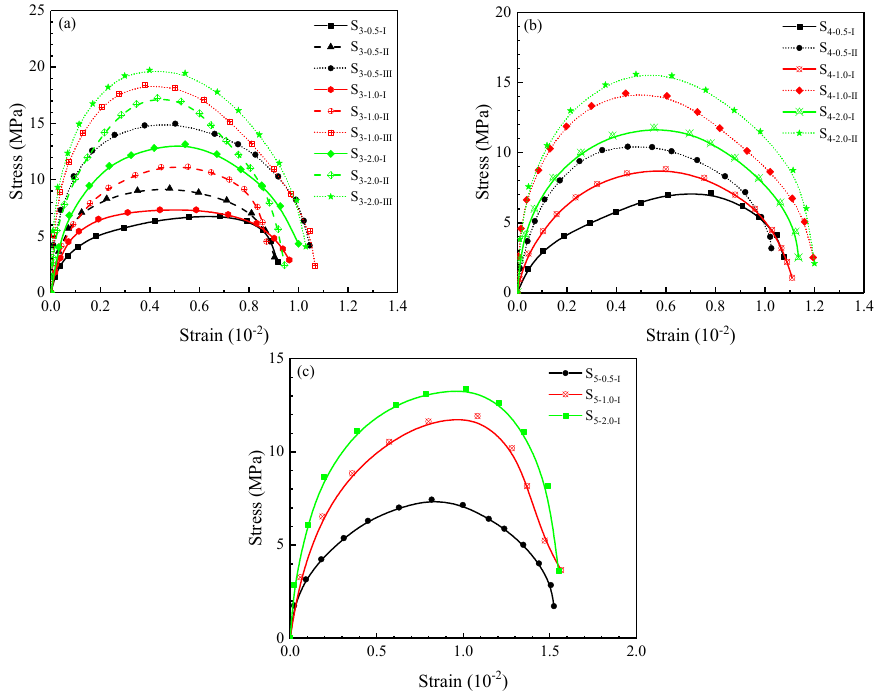
Figure 6. Dynamic stress–strain curves for different PSDs: ( a ) S 3 series; ( b ) S 4 series; ( c ) S 5 series.